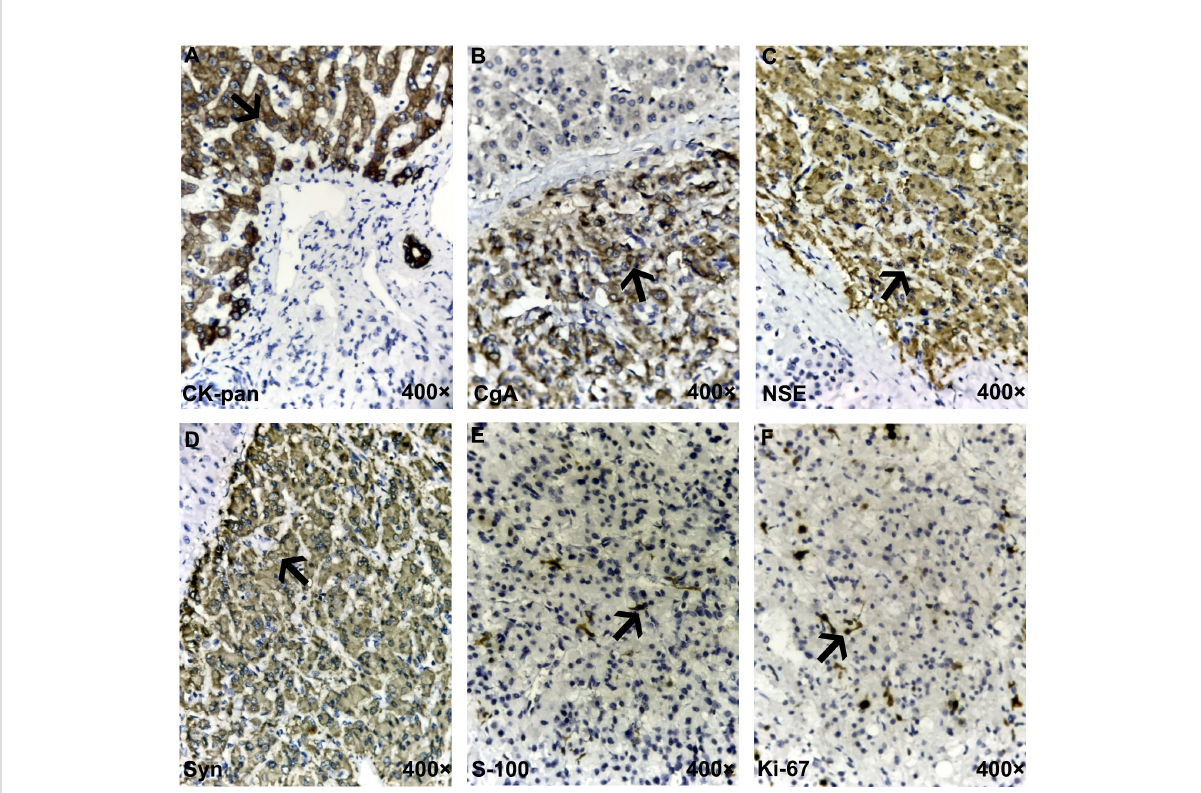
FIGURE 4 Immunohistochemistry for the gallbladder paraganglioma. (A) The difference between neuroendocrine epithelial tumor (NET/NEC) and neuroendocrine non-epithelial tumor (PHEO/PARA) is that the former expresses broad-spectrum pan-cytokeratin (CK-pan), which was negative here, meaning that the tumor was of non-epithelial origin. (B – D) Traditional general neuroendocrine markers, including chromogranin A (CgA), neuron-speci fi c enolase (NSE), and synaptophysin (Syn), were all positive. (E) S-100 staining highlights surrounding sustentacular cells. (F) The Ki-67 proliferation index of tumor cells was 10%. The typical positive expression of each marker in the fi gures is indicated by black